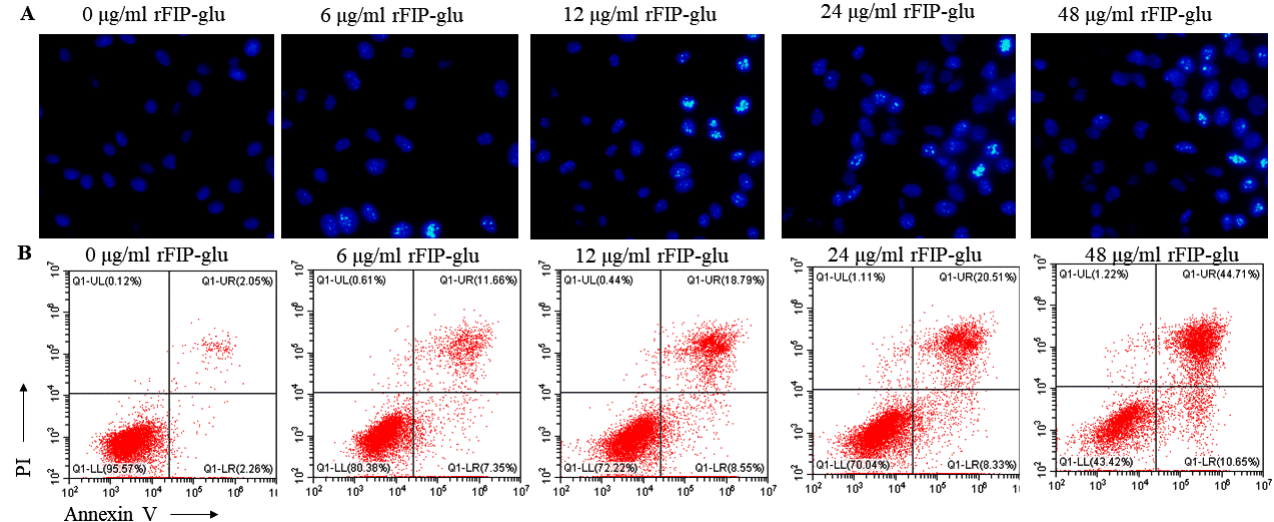
Figure 3. rFIP-glu inducing the apoptosis of B16 cells. ( A ) Hoechst 33258 staining of B16 cells under a fluorescence microscope (400 × ). ( B ) B16 cells stained by Annexin/PI and analyzed by flow